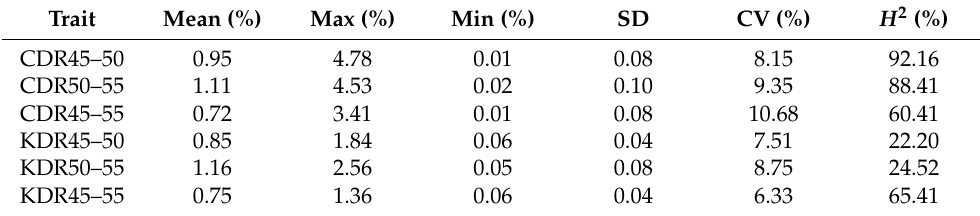
Max, maximum; Min, minimum; SD, standard deviation; CV, coefficient of variation; H 2 , broad- sense heritability. CMC45, CMC50, and CMC55 represent cob moisture content on the 45th, 50th, and 55th days after pollination, respectively; KMC45, KMC50, and KMC55 represent kernel mois- ture content on the 45th, 50th, and 55th days after pollination, respectively; CDR45 – 50, CDR50 – 55,